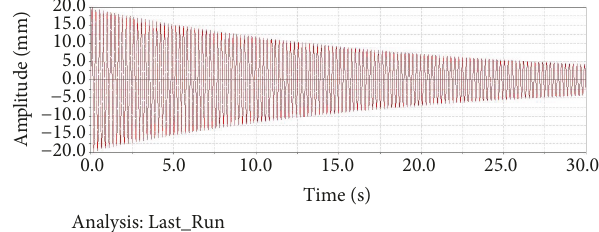
Figure 8: Vibration response of the flexible arm (no damping).